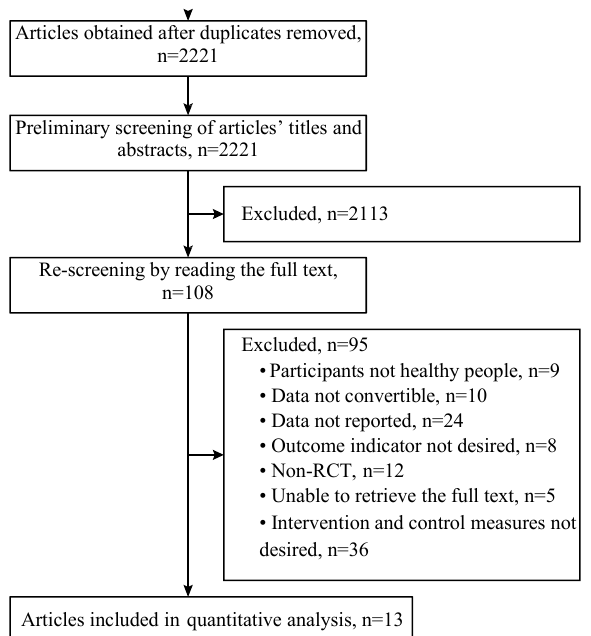
Fig. 2. Flow of studies within the review